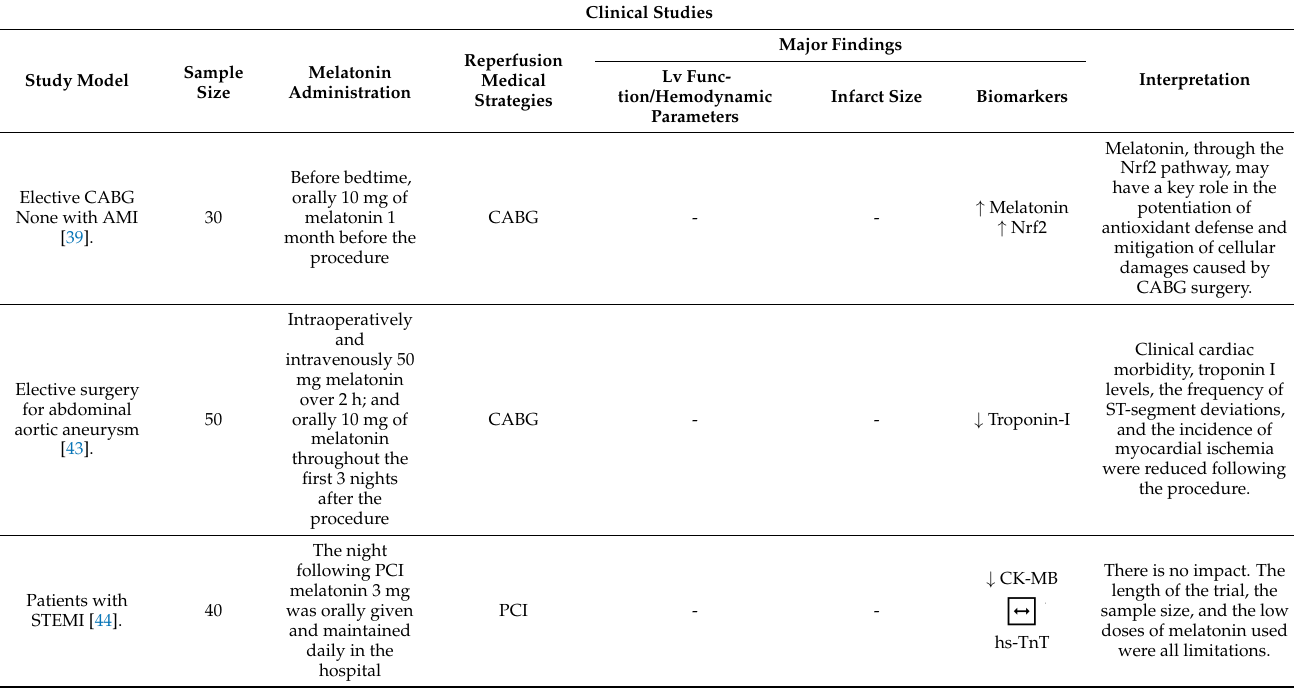
Table 2. Clinical studies on melatonin’s efficacy in ischemia-reperfusion injury. Coronary artery bypass graft (CABG), acute myocardial infarction, (AMI), nuclear factor erythroid 2-related factor (Nrf2), ST-elevation myocardial infarction (STEMI), percutaneous coronary intervention (PCI), crea- tine kinase-MB (CK-MB), high sensitive troponin-T (hs-TnT), left ventricular ejection fraction (LVEF), heart ratio (HR), cardiac troponin I (cTn-I), myocardial ischemia/reperfusion (MI/R), left ventricular end-diastolic volume (LVEDV), left ventricular end-systolic volume (LVESV), left ventricle (LV), malondialdehyde (MDA), tumor necrosis factor alpha (TNF- α ), N-acetyl cysteine